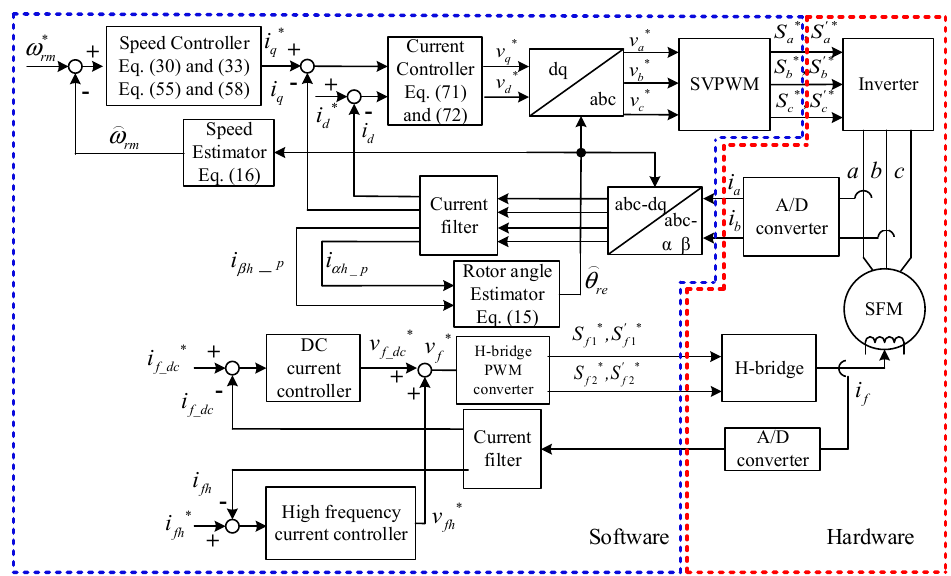
Figure 5. Control block diagram of proposed sensorless drive system.